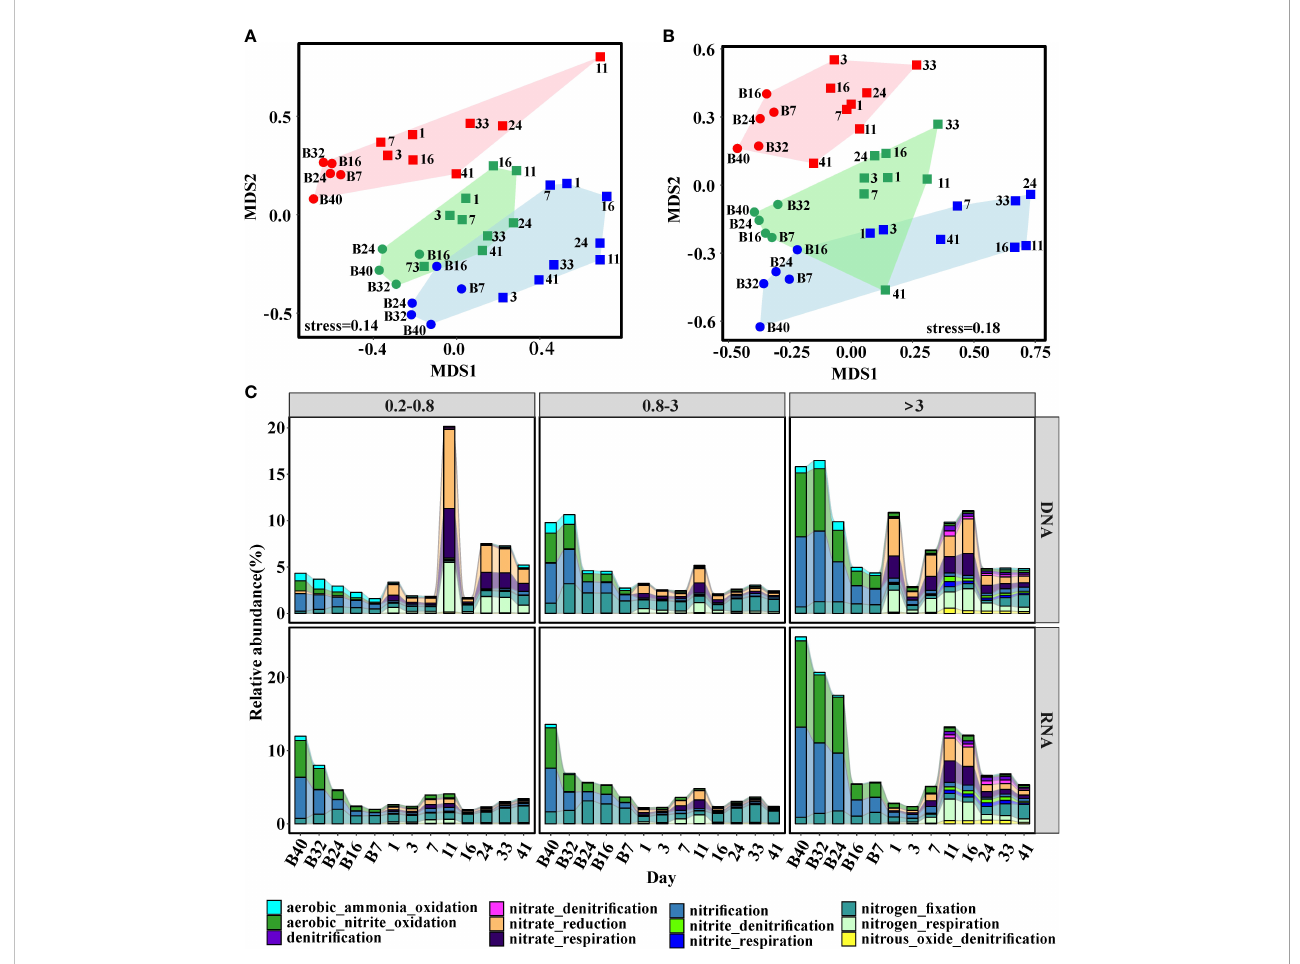
FIGURE 5 Nonmetric multidimensional scaling (NMDS) of bacterial function composition based on Bray – Curtis dissimilarities. (A) DNA libraries; (B) RNA libraries. Points represent bacterial groups from different size fractions. Red: 0.2 – 0.8 m m; Green: 0.8 – 3 m m; Blue: >3 m m. (C) Changes of genes involved in the predicted nitrogen metabolism. Functional pro fi les were predicted by FAPROTAX. The circle and square represented samples collected before and after the addition of freshwater,